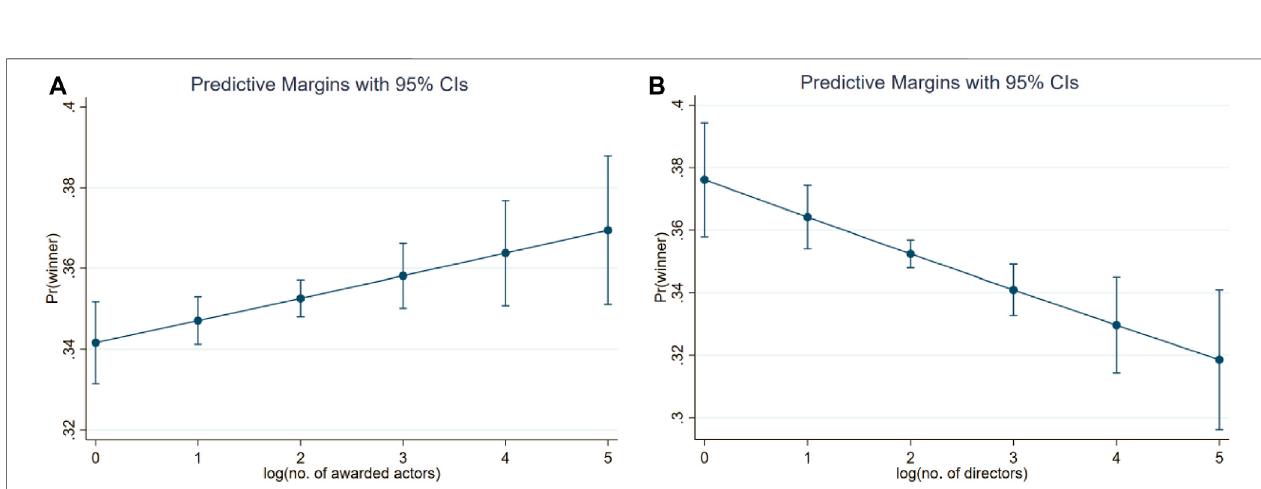
FIGURE 8 | Predictive marginal effects for collaboration network. (A) Predictive marginal probability with increasing number of awarded actors. The number of awarded actors among collaborators will increase the probability of prizewinning. (B) Predictive marginal probability with the increasing number of directors has a negative impact on prizewinning. The logarithmic bases are the natural logarithms in the plots.